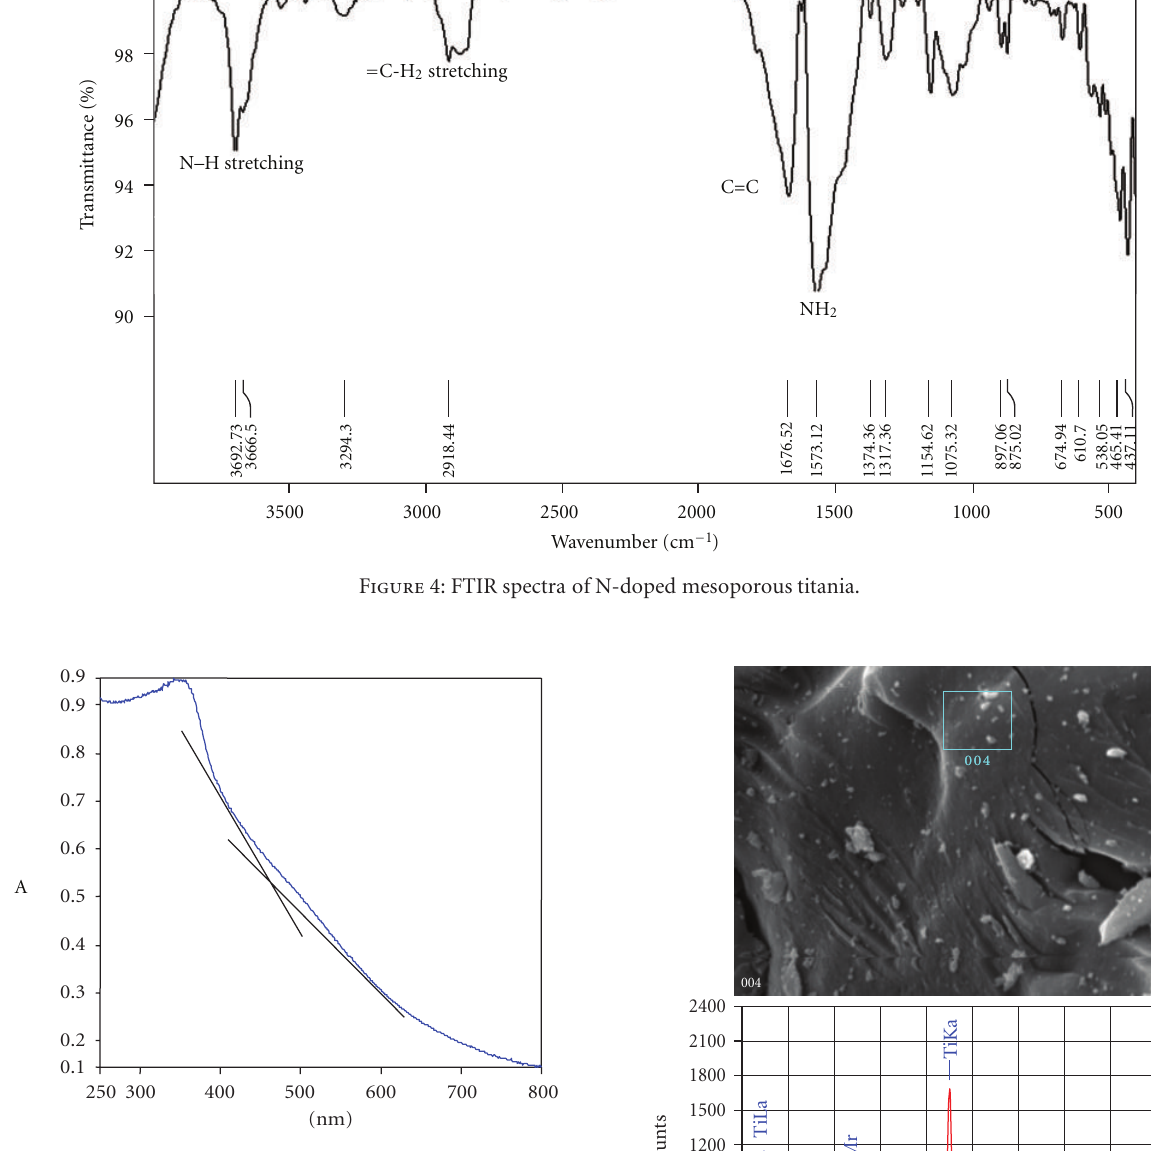
Figure 5: UV-Vis spectra of N-doped mesoporous titania.